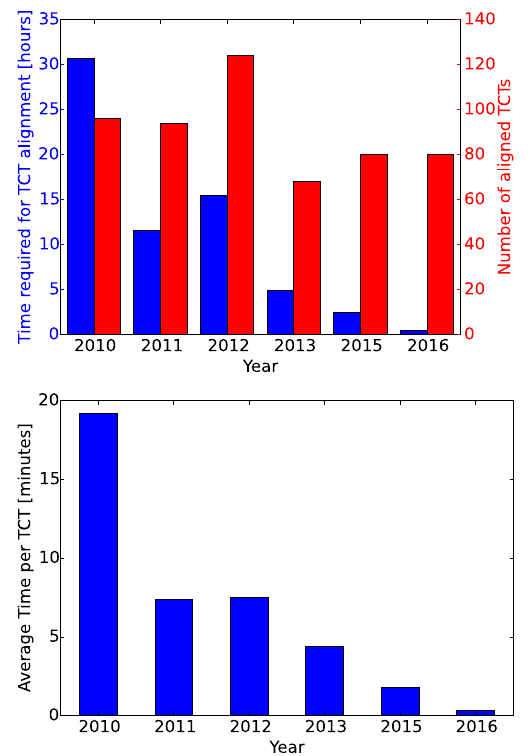
FIG. 6. The total time required for TCT alignment, the number of TCT alignments and the average time required to align a TCT collimator over the